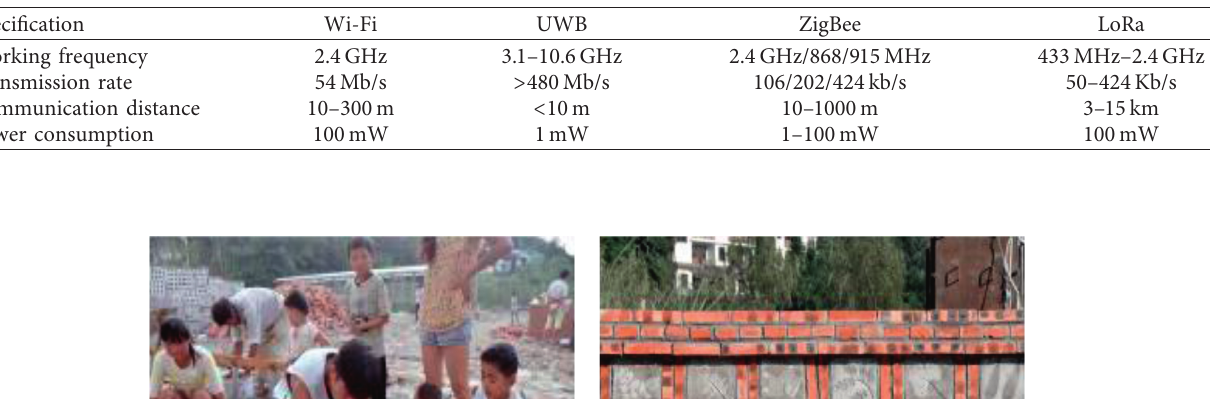
Table 5: Comparison of wireless transmission technologies.